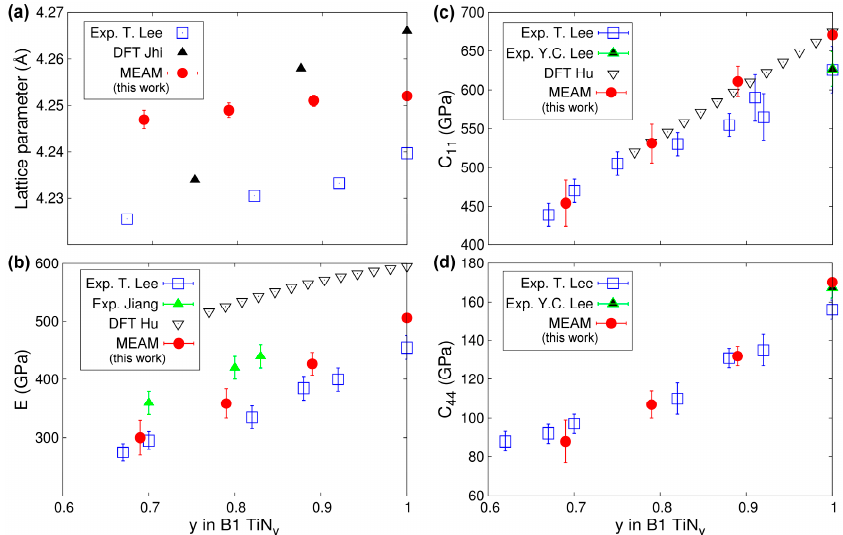
Figure 8. MEAM TiN y (0.69 ≤ y ≤ 1) lattice parameters and elastic constants as function of N content y calculated at 0 K in comparison with experimental (T. Lee = Ref. [84], Y.C. Lee = Ref. [85], Jiang = Ref. [128]), and ab initio (DFT Jhi = Ref. [126], DFT Hu = Ref. [127]) results.